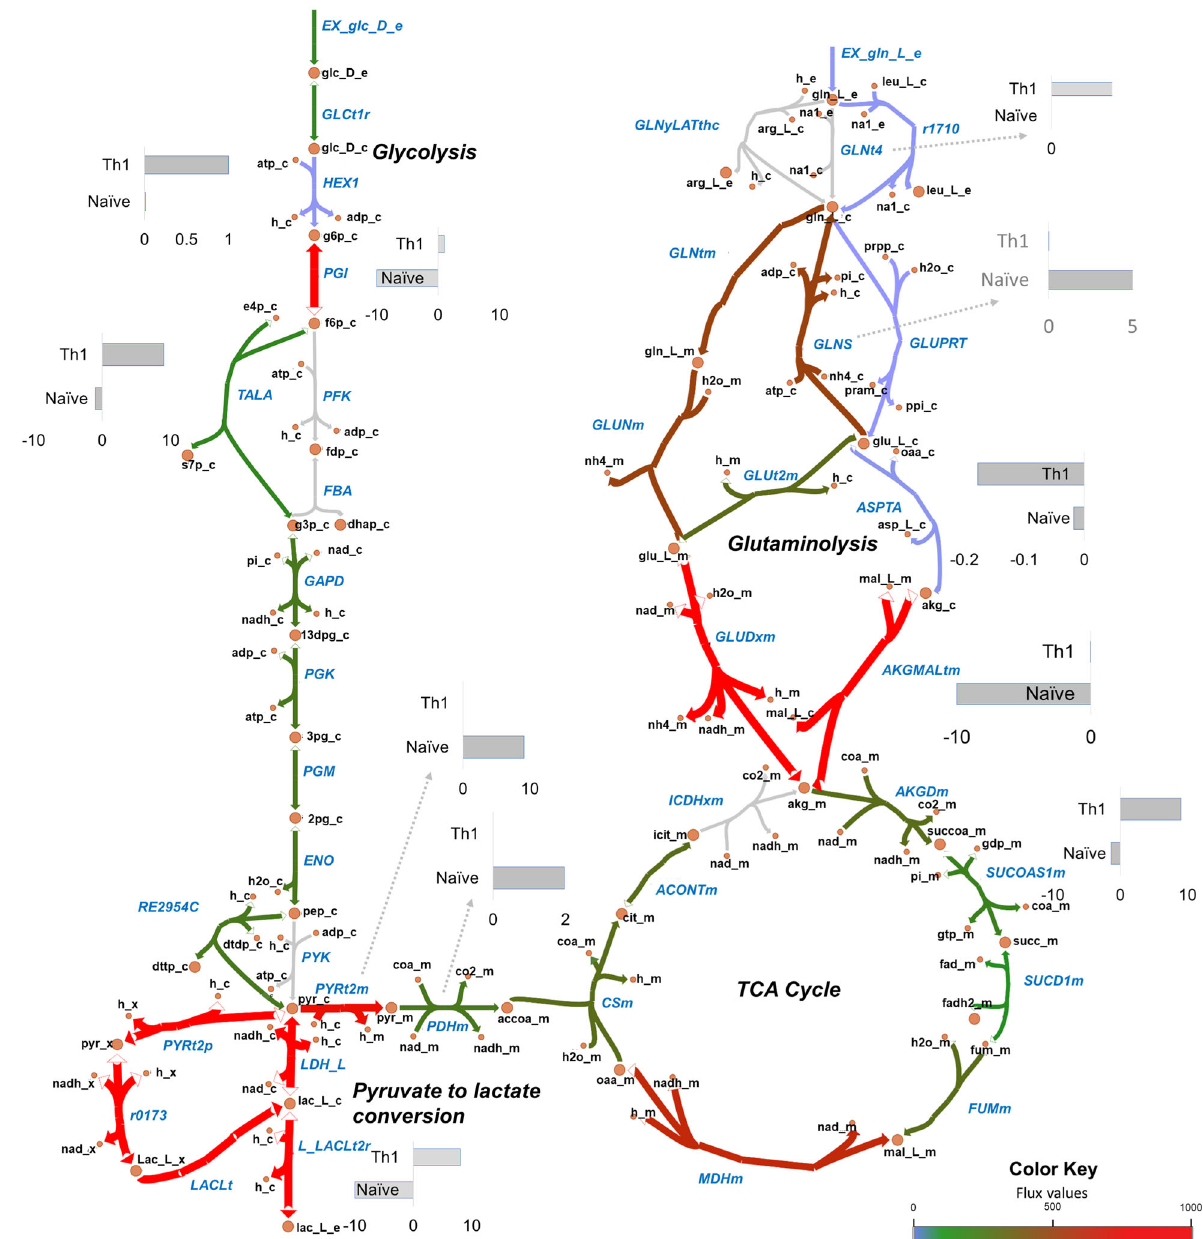
Fig. 3 Flux map of metabolic pathways active in CD4 + T-cell metabolic models. Escher map showing fl uxes through glycolysis, glucose to lactate conversion, TCA cycle, glutaminolysis in naïve model. The colors represent the reaction fl uxes in the naïve model. Gray arrow color corresponds to zero fl ux. Gradients of blue, green, and red correspond to non-zero fl ux. For key reactions, fl ux comparison between naïve and Th1 is shown through bar plots. Both naïve and Th1 models convert pyruvate to lactate (aerobic glycolysis). In glycolysis, the naïve model had the reverse direction fl ux through PGI reaction, while Th1 cells have forward direction fl ux. All the models exhibit an uptake of glutamine that ultimately forms α -Ketoglutaric acid (glutaminolysis). GLNtm (glutamine transporter) and GLUNm (convert glutamine to glutamate) reactions are active in the naïve model and not in models that use different routes for glutamine to glutamate